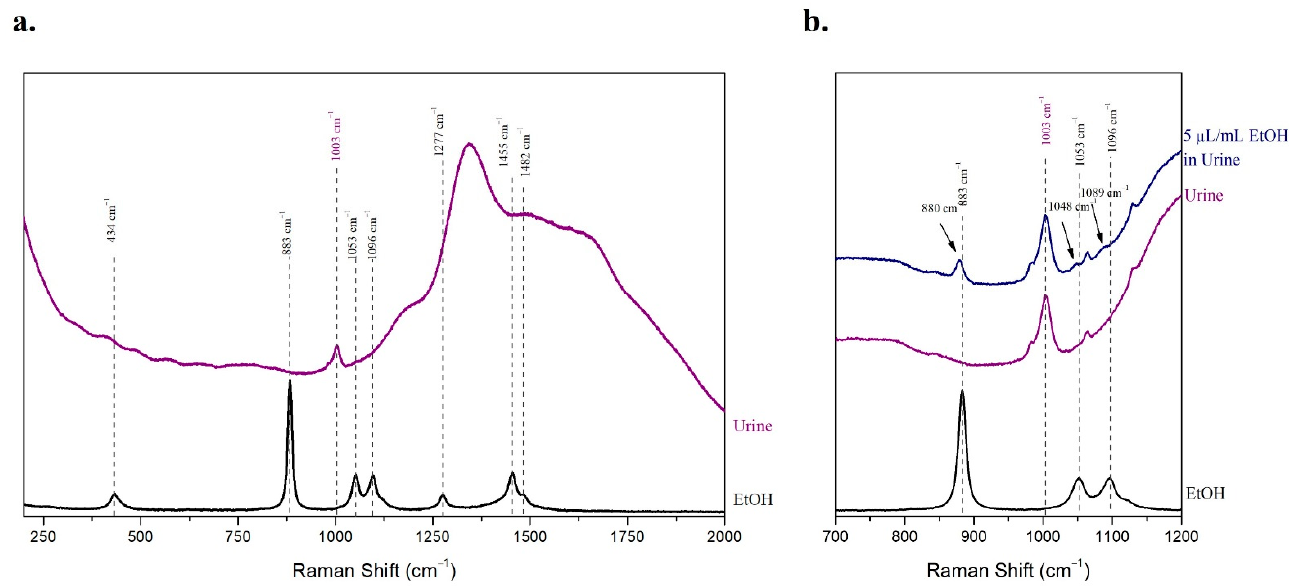
Figure 1. The Raman spectra of ethanol, human urine, and the 5 µ L/mL ethanolic sample in human urine were acquired. ( a ) The characteristic peaks of ethanol and human urine are noted with dashed lines; ( b ) the characteristic peaks of ethanol were shifted in the sample of 5 µ L/mL ethanol in human urine, and the shifted peaks are noted with arrows.